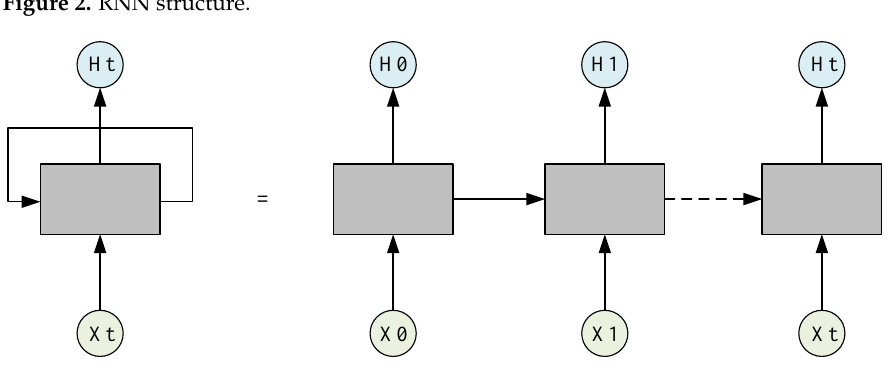
Figure 3. Cyclic unit